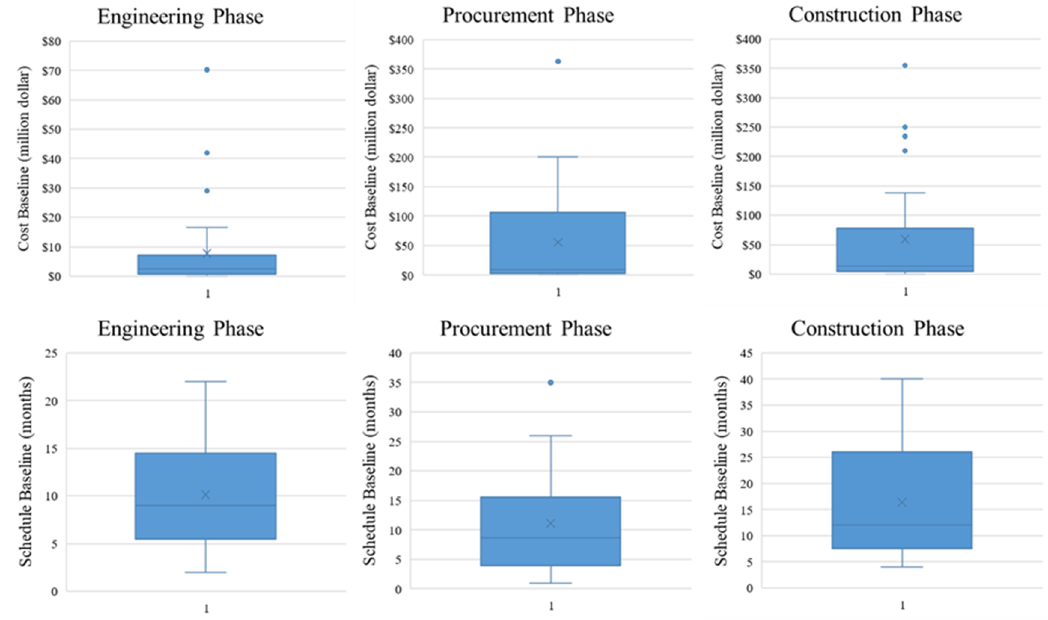
Figure 4. Phase-Based Budget and Schedule Box-Plots.